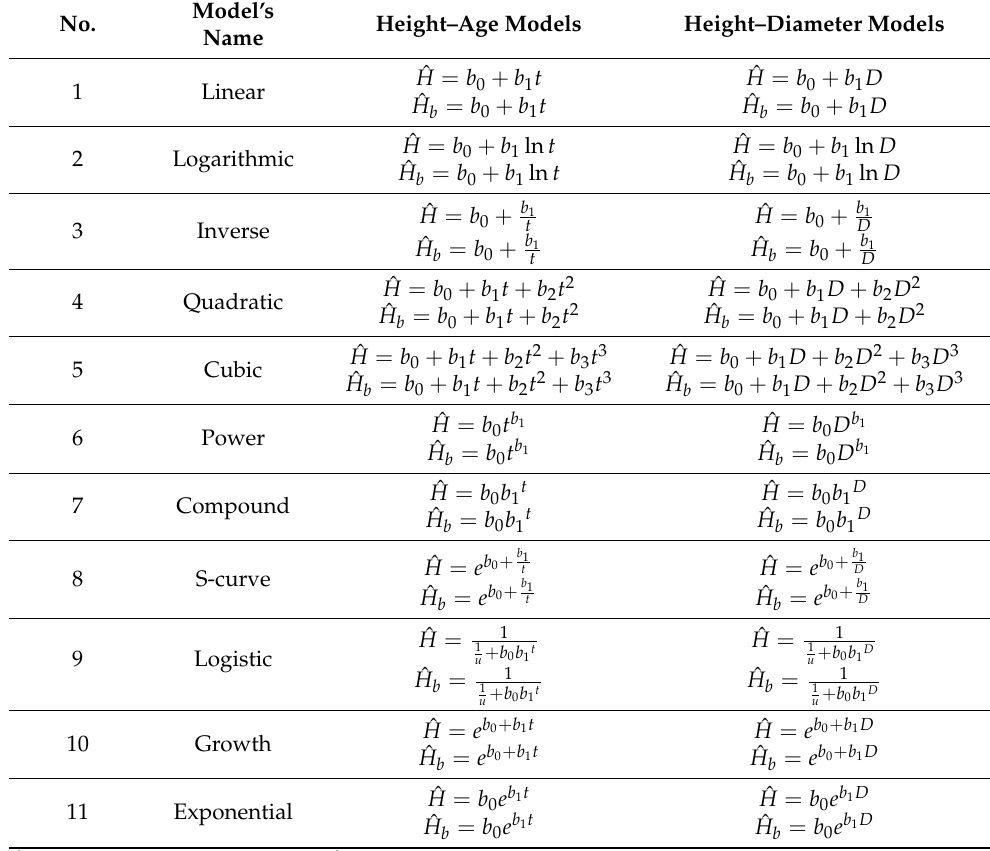
Table 2. Models fitted to input